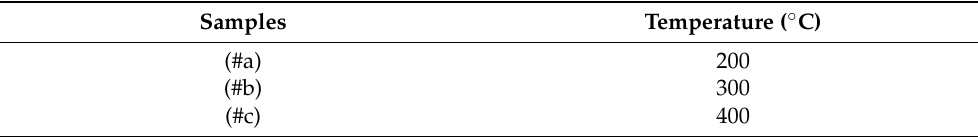
Table 1. Codes for the different ZnO films prepared by the plasma-enhanced chemical vapor deposi- tion (PECVD) technique on Si(001) substrates heated at 200, 300, and 400 ◦ C during film